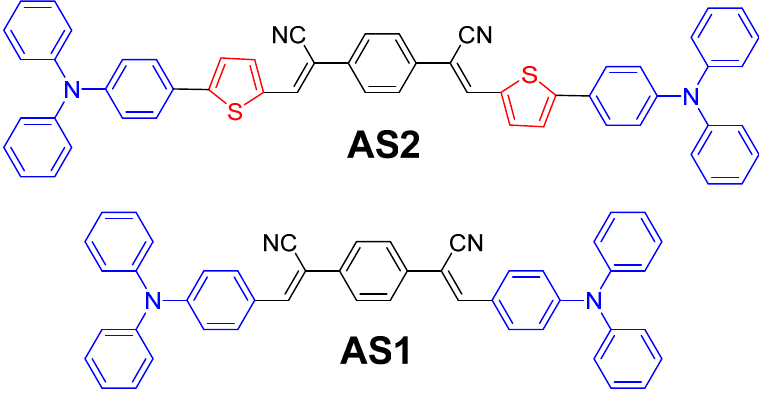
Figure 1. Molecular structures of the newly designed AS2 and reference AS1 materials investigated in this study.